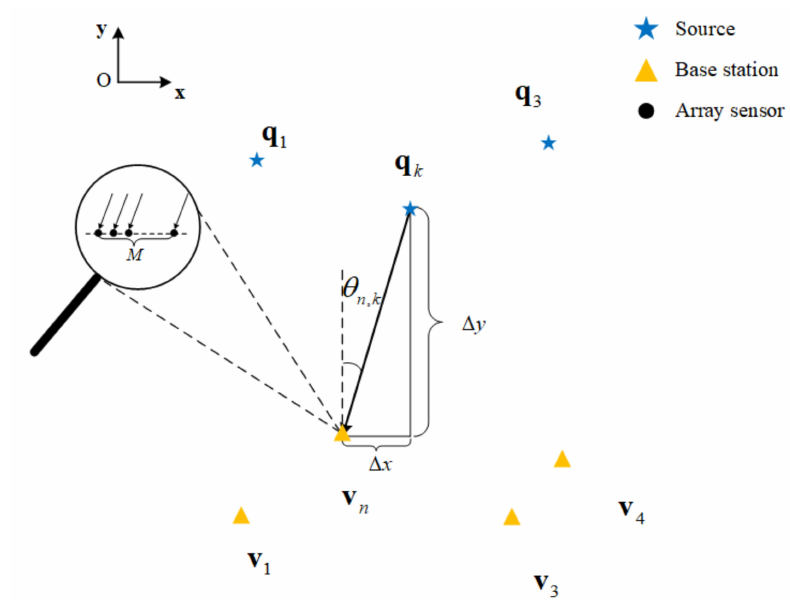
Figure 1. The localization scenario for multiple sources with multiple